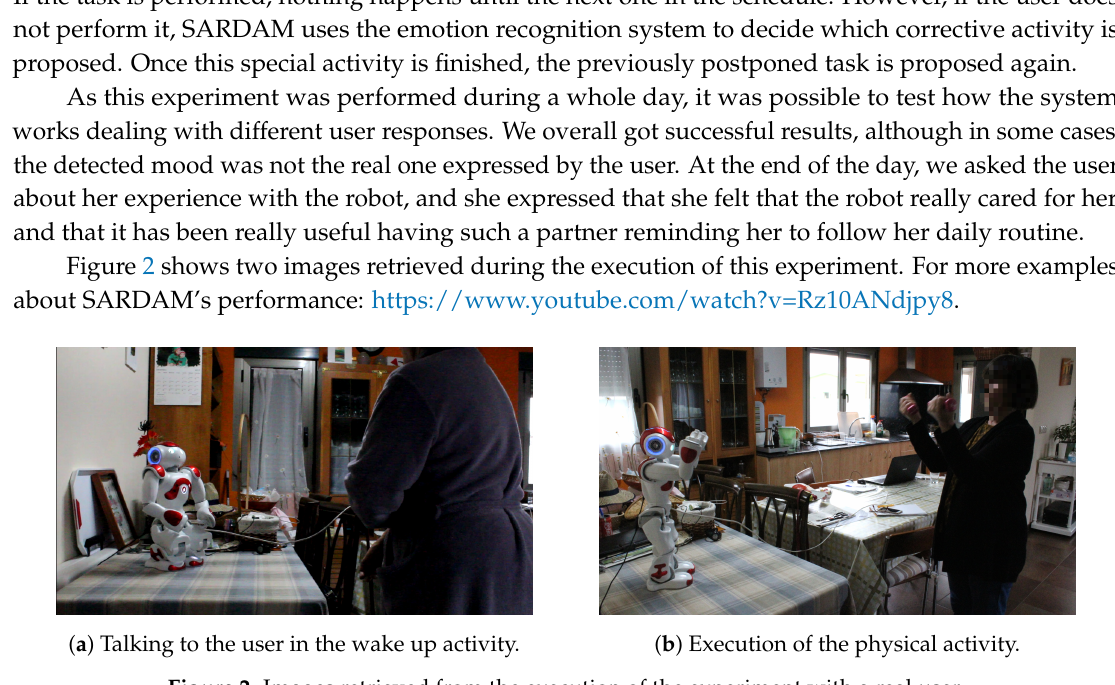
Figure 2. Images retrieved from the execution of the experiment with a real